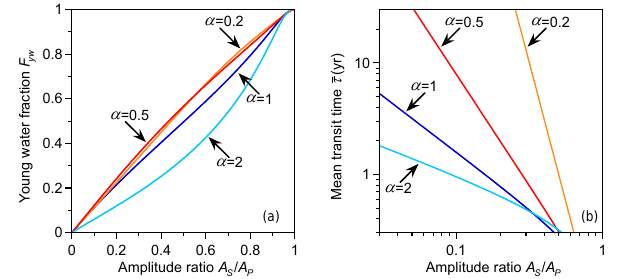
Figure 12. Sensitivity analysis showing how variations in shape fac- tor α affect young water fractions F yw (a) and mean transit times τ (b) inferred from the amplitude ratio A S /A P of seasonal tracer cycles in precipitation and streamflow. Curves are shown for the four shape factors shown in Figs. 2 and 3. For a plausible range of uncertainty in the shape factor (0.5 <α < 1; see Sect. 2.1), es- timated young water fractions vary by a few percent (a) , whereas estimated mean transit times vary by large multiples (note the log- arithmic axes in b ). (a) shows the fractions of water younger than τ yw = 2.27 months, which are closely approximated by A S /A P if α = 1 (the dark blue curve). In (b) , the axis scales are chosen to span transit times ranging from several months to several years, as is commonly observed in transit-time studies (McGuire and Mc- Donnell,